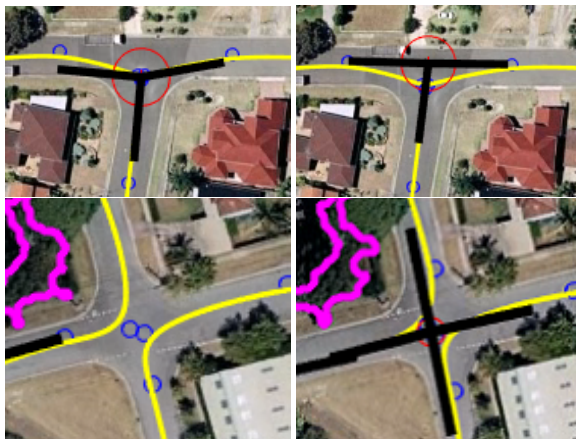
Figure 7: Typical cases of T- and X-junction revision: junction centres are shown as red circles and branches are shown as black lines.